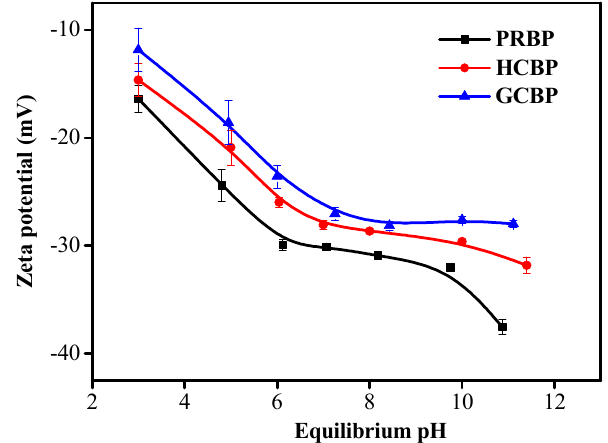
Figure 6. The zeta potential of PRBP, GCBP, and HCBP. Experimental conditions: m = 2 g/L, T = 25 ± 1 °C.